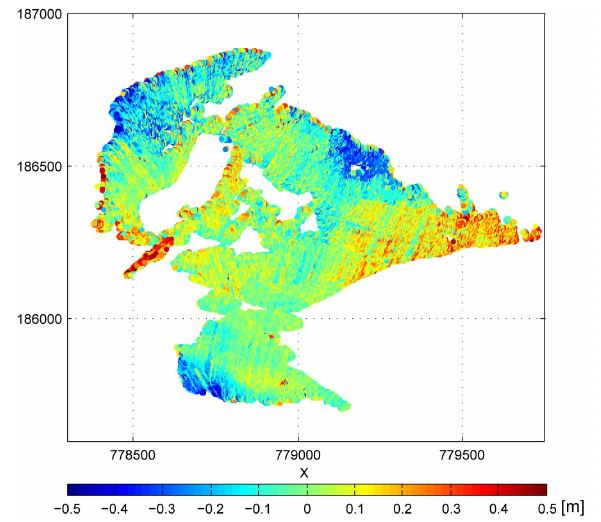
Fig. 2. Spatial distribution of the deviation in z-direction [m] be- tween ALS and TLS survey for 26 April